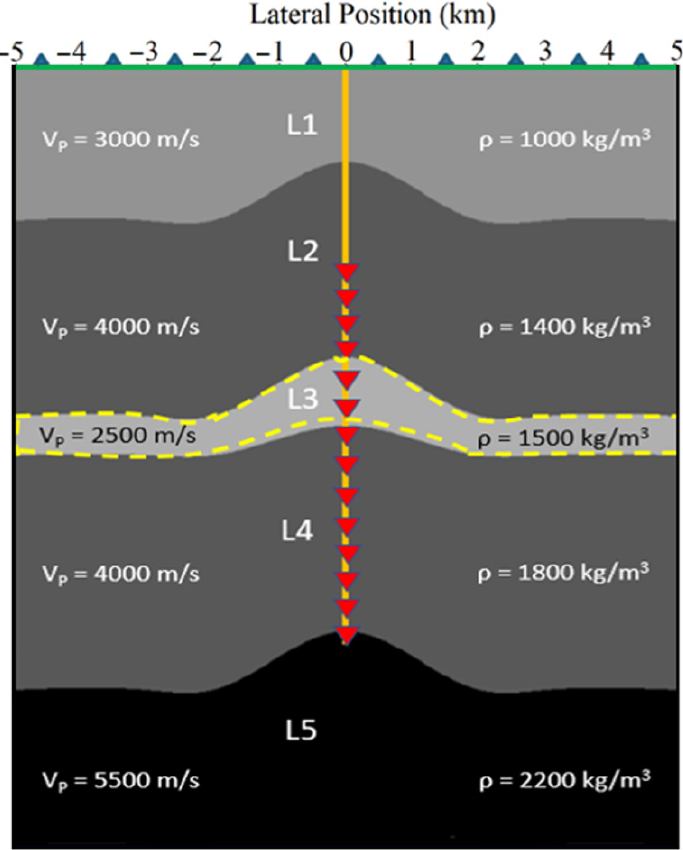
Figure 7. An acoustic velocity model with anticlines that are combined surface seismic and zero-offset VSP geometry. Blue triangles correspond to 201 geophones that are placed on the free surface. L3 (covered by yellow-dashed area) corresponds to the coal layer. The red triangles in the vertical direction (101 geophones) show the array of the geophones for VSP acquisition.